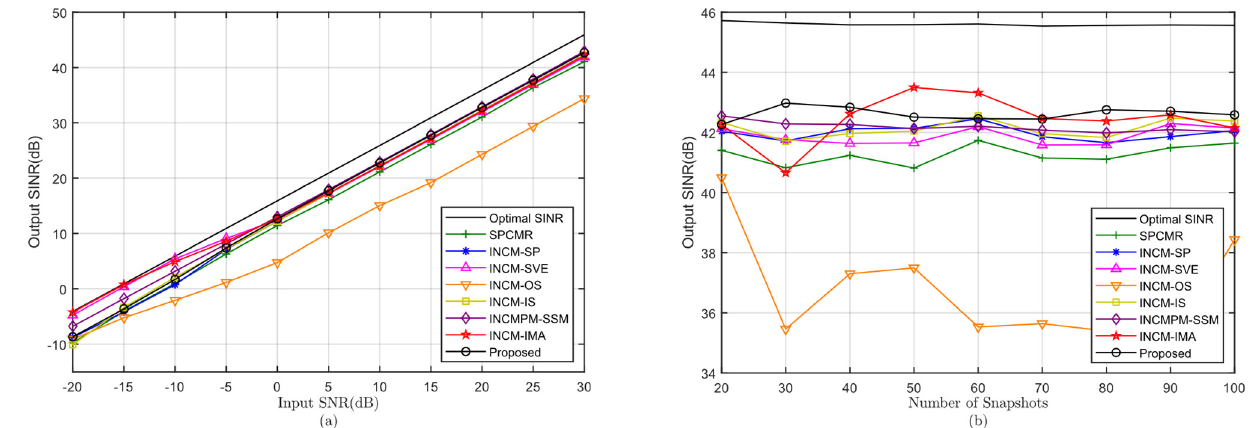
Figure - 5. Example 4: output SINR vs.: ( a ) input SNR; ( b ) number of snapshots. Figure 5. Example 4: output SINR vs.: ( a ) input SNR; ( b ) number of